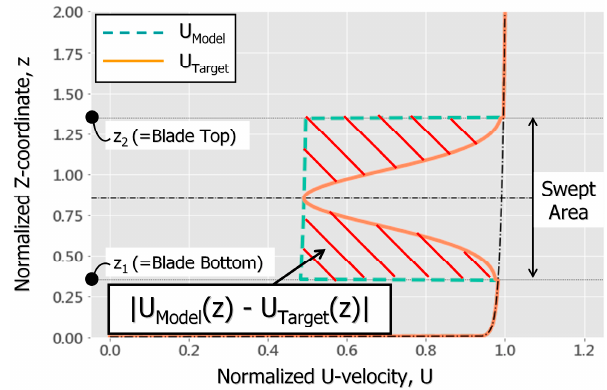
Figure 11. Image diagram of the wake error rate related to the time-averaged wind speed distribution in the wind turbine wake region.